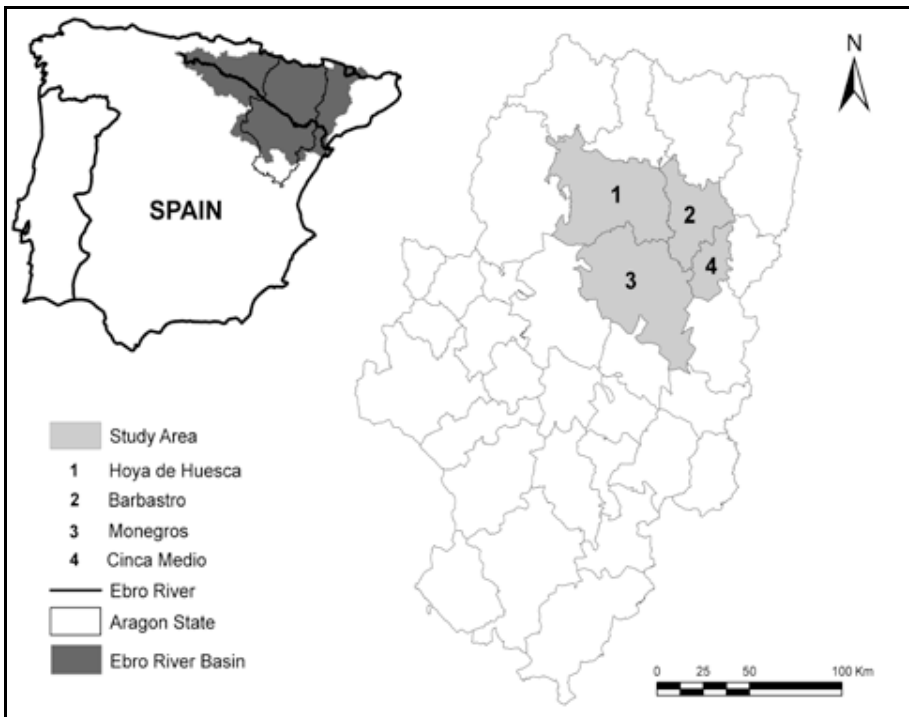
Figure 1. Map of the study